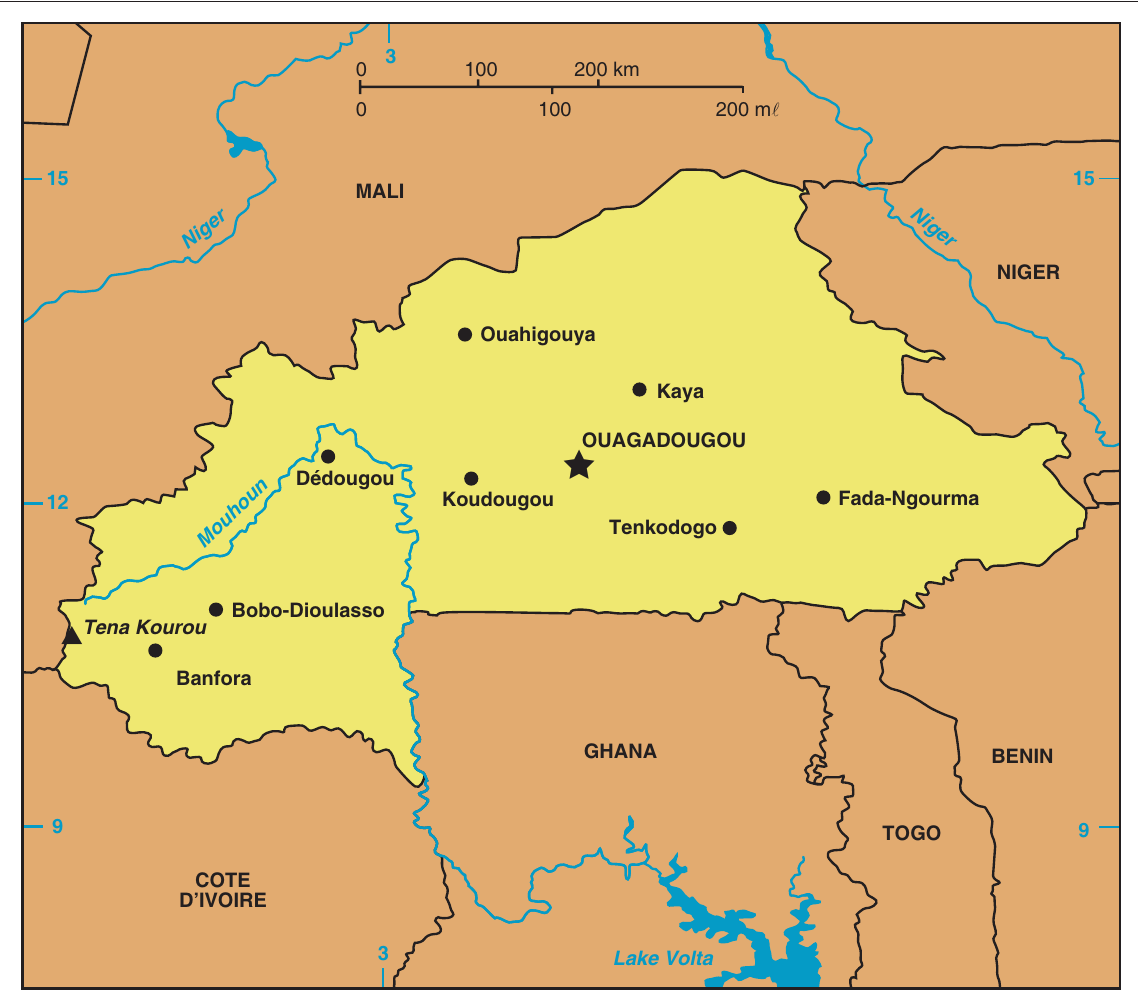
FIG. 1 Burkina Faso showing the location of the study area